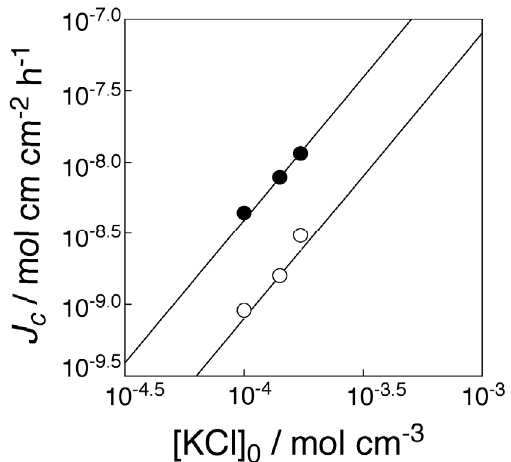
Figure 5. Dependence of facilitated KCl transport and simple diffusion fluxes on KCl feed concentration at the operating temperature of 50 °C (323 K) ([DB18C6] = 1.32 × 10 − 4 mol·cm − 3